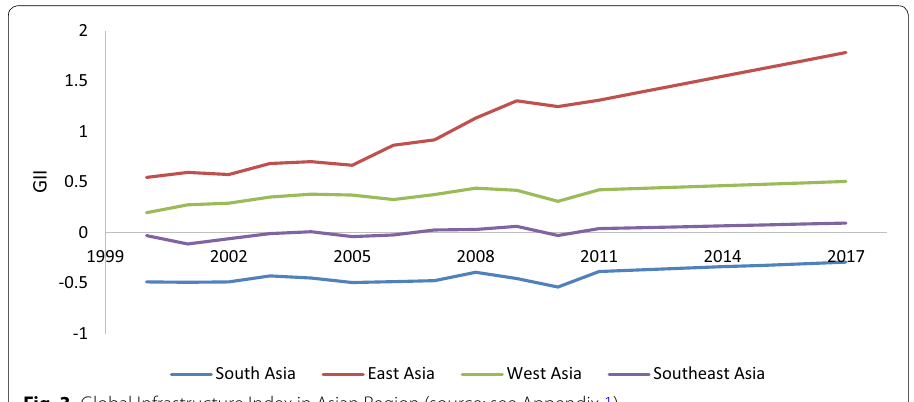
Fig. 3 Global Infrastructure Index in Asian Region (source: see Appendix